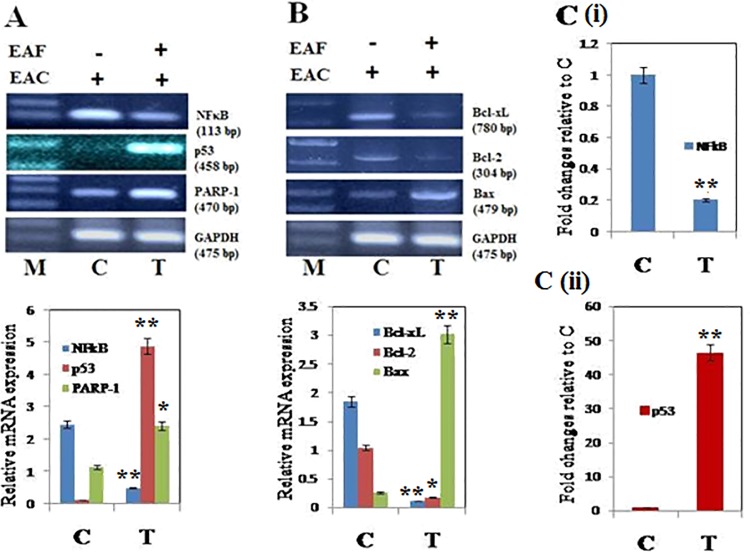
Analysis of mRNA of pro-and anti-apoptotic genes.Expression of (A, upper panel) NFκB, p53, and PARP-1 and (B, upper panel) Bcl-xL, Bcl-2, and Bax genes was analyzed by semi-quantitative RT-PCR in EAF-untreated EAC control mice (C) and EAF-treated EAC mice (T). The positions of the genes along with their length are indicated on the left in bp. The bottom panel shows the PCR products of GAPDH as a control. GAPDH transcript was used to normalize the expression levels. Relative expression of (A, lower panel) NFκB, p53, and PARP-1 and (B, lower panel) Bcl-xL, Bcl-2, and Bax genes was determined by a densitometric method. (C (i), upper and C (ii) lower panels) Fold changes of NFκB and p53 relative to untreated control (C) was determined by a densitometric method. Error bars indicate the S.D. from three different experiments. M represents 1 kb DNA ladder; C and T indicate control and EAF-treated mice, respectively. The asterisks indicate that EAF treated tumor bearing mice is significantly different (*p < 0.05, **p < 0.01, and ***p < 0.001) from untreated control group.